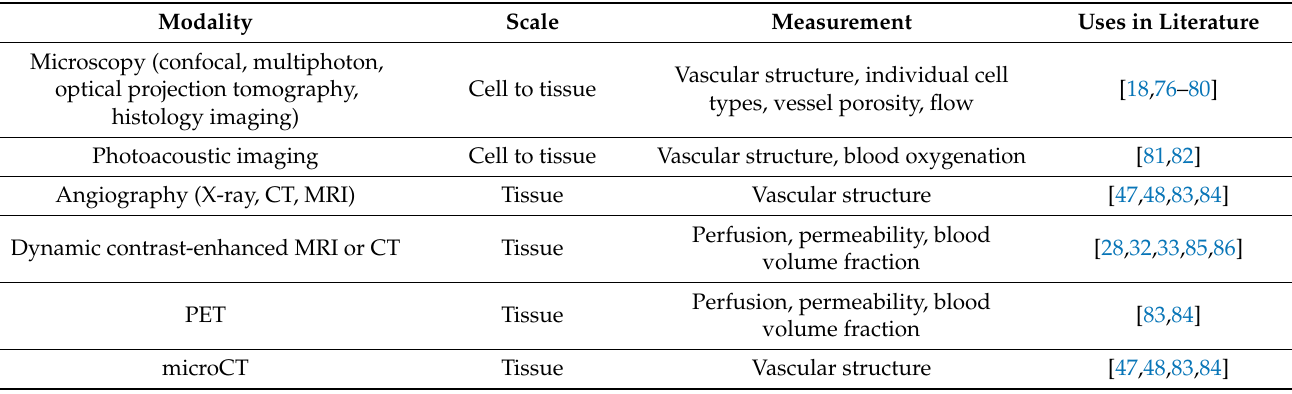
Table 1. Imaging techniques for visualizing vasculature and angiogenesis at cell scale and tissue scale. Modality Scale Measurement Uses in Literature Microscopy (confocal, multiphoton, optical projection tomography, histology